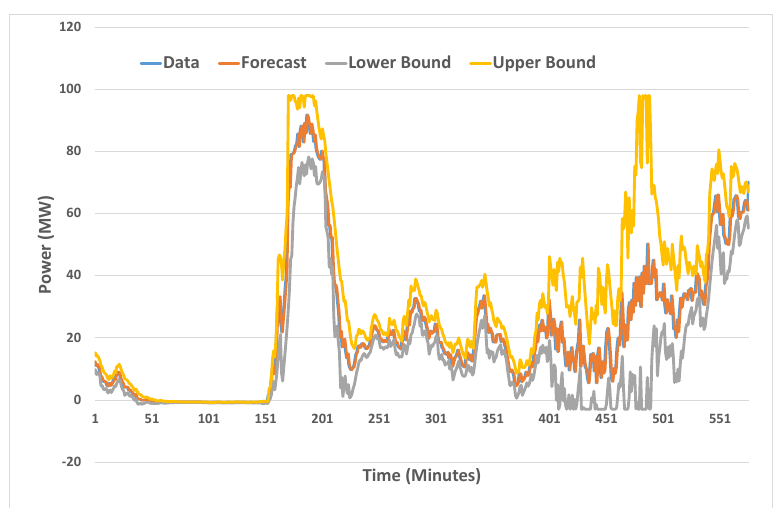
Figure 7. Probabilistic forecasting example for Snowtown wind farm.